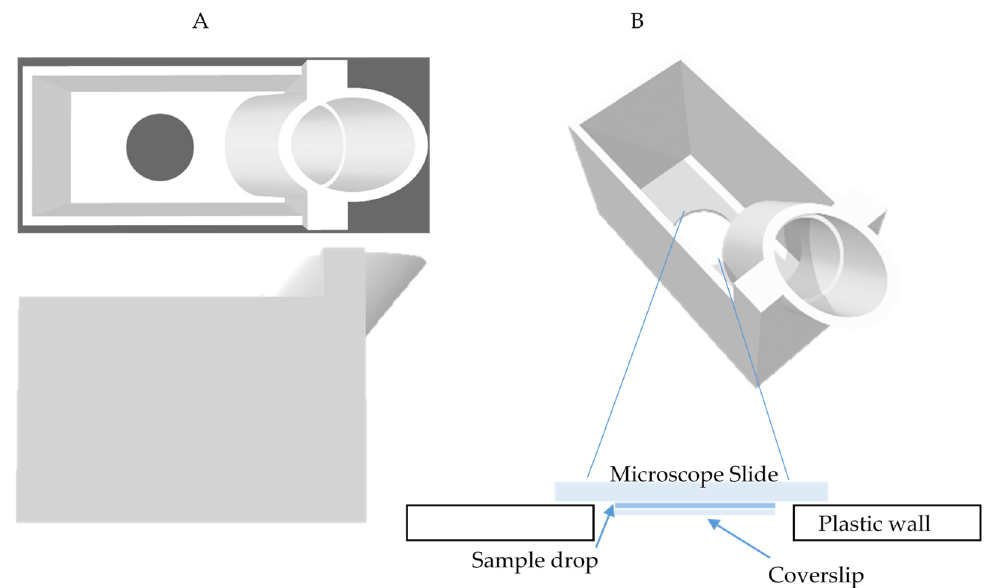
Figure 4. Image of the 3D printed setup for the simultaneous exposure and observation under the microscope of a small liquid volume. ( A ) Top and side view of our system. ( B ) Zoom on the bottom part of the device (schematic view). The sample is placed under the circular coverslip visible at the bottom of the device and the microscope slide. The transducer is fixed in the inclined upper